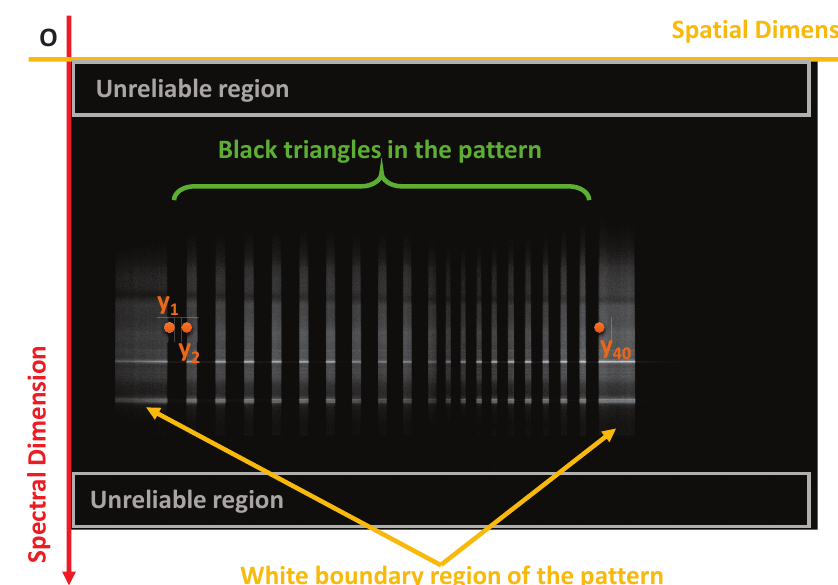
Figure 4. An image captured by a hyperspectral line-scan camera facing the calibration target shown in Figure 3. The camera gathers data across the view plane. In the 2D image returned by the camera, the x -axis records spatial information across the view plane and the y -axis records spectral information.